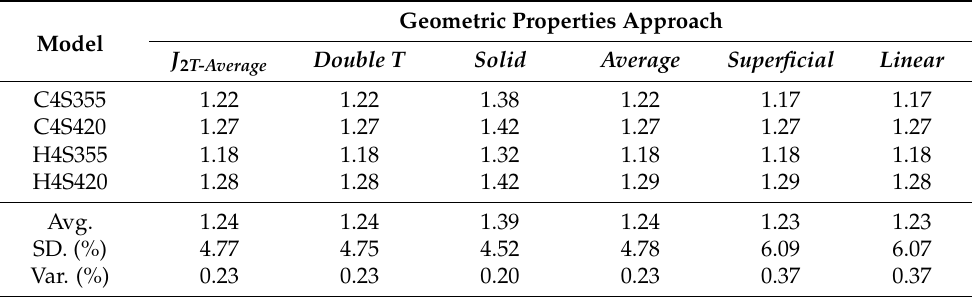
Table 11. M u-Theoretical / M u-test obtained by the calculation procedure of AS4100:1998 R2016 [105]. Model